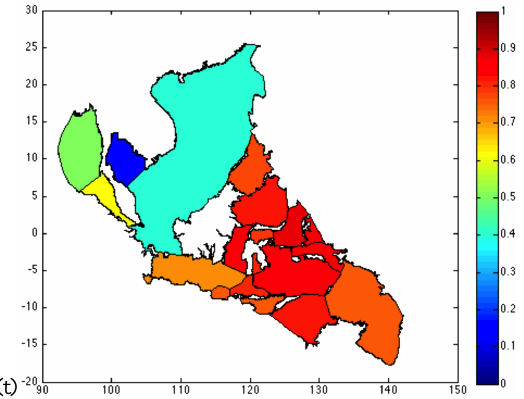
Figure 3. Comparison between the HLK reconstruction and the tide gauge data. Each circle represents a tide gauge used in the recon- struction. The color of each point represents the correlation between the reconstruction and tide gauge, while the size of the circle rep- resents the length of the record available for comparison (largest circles relate to records that span the full time period from 1950 to